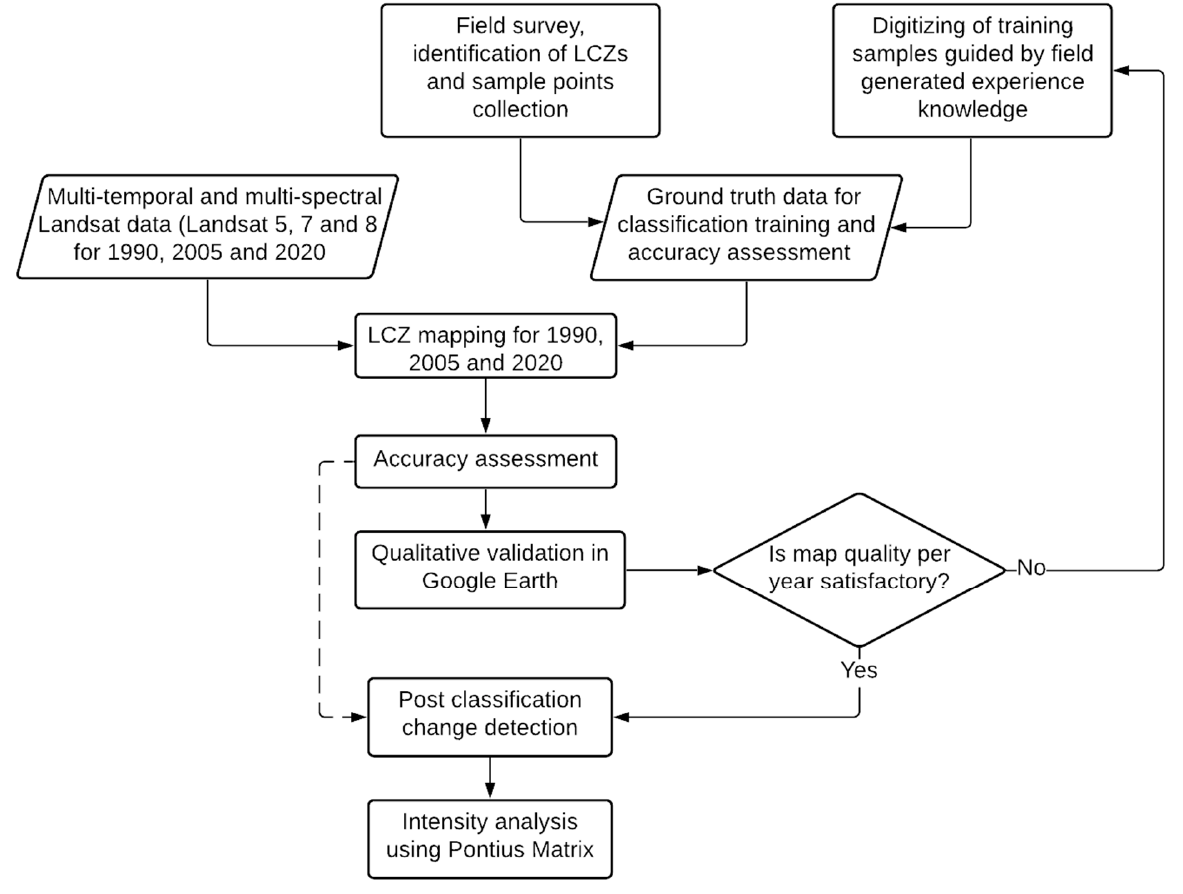
Figure 2. Flowchart showing summary of procedures used in this